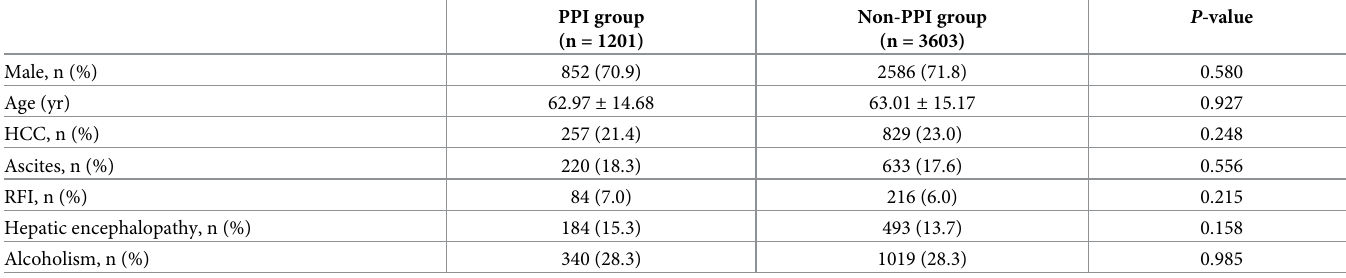
Table 1. Demographic characteristics of cirrhotic patients with pneumonia, with and without concomitant use of PPIs.